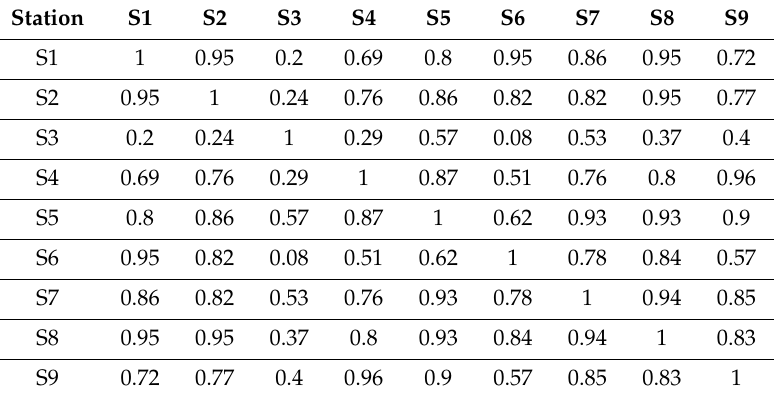
Table 2. Correlation coe ffi cients of PM 2.5 among all monitoring stations.